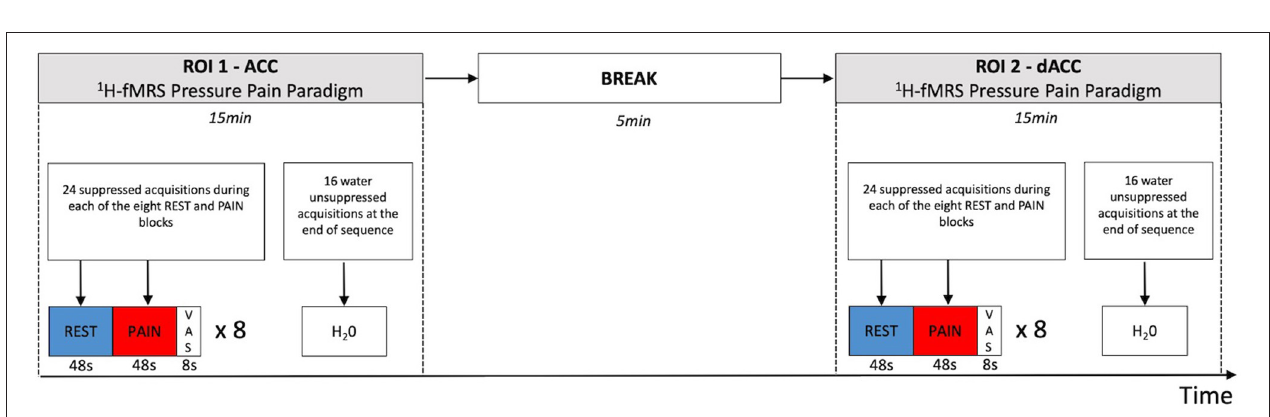
FIGURE 2 | Temporal sequence of 1 H-fMRS measurements and regions. 1 H-fMRS measurements were first acquired from ROI 1 (ACC) during the pressure pain paradigm. There was then a 5min break and subsequently 1 H-fMRS measurements were acquired from ROI 2 (dACC) during a second run of the same pressure pain paradigm. The 1 H-fMRS sequence was identical for each ROI (T R = 2,000ms, T E = 105ms, phase cycle length = 2). Twenty four suppressed acquisitions were acquired during each of the eight REST and PAIN blocks with 16 water unsuppressed acquisitions acquired at the end of the 1 H-fMRS sequence for each run.